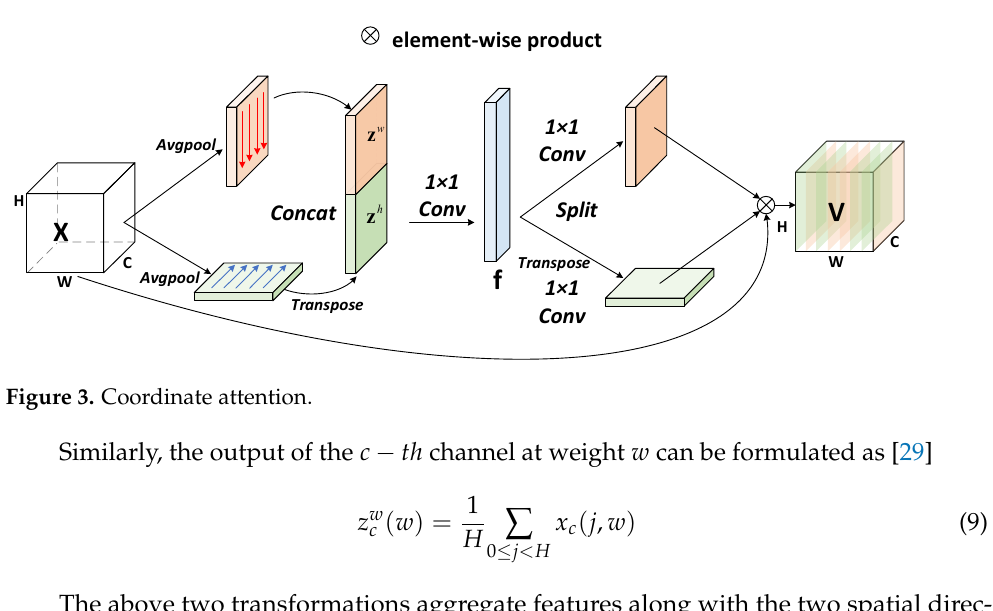
Algorithm 1: Design Kaiser window to approximate the anti-aliasing filter